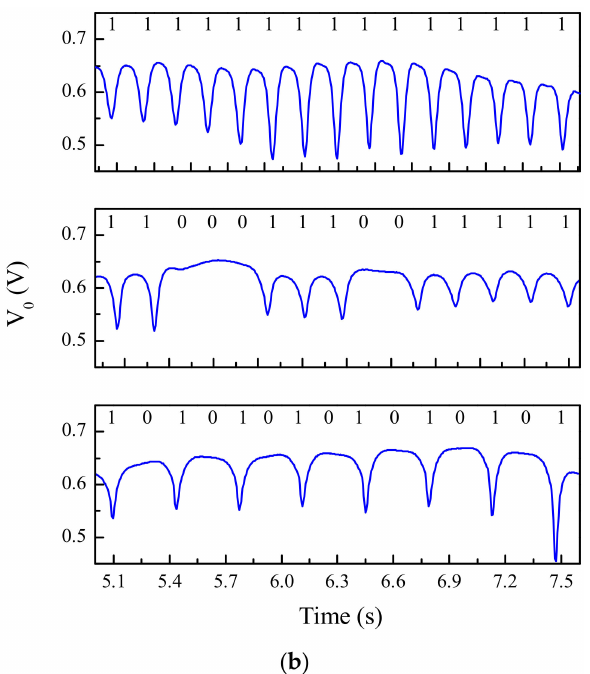
Figure 17. ( a ) Photograph of 15-bit encoders with the indicated ID codes; ( b ) corresponding envelope functions. The inclusions have a length of 18 mm and a width of 0.4 mm, whereas their separation is 3 mm (providing an encoder period of 3.4 mm). The estimated thickness of the 3D-printed substrate is 0.2 mm, and the estimated thickness of the dielectric inclusions is 0.2 mm. Reprinted with permission from [25]. Copyright 2020